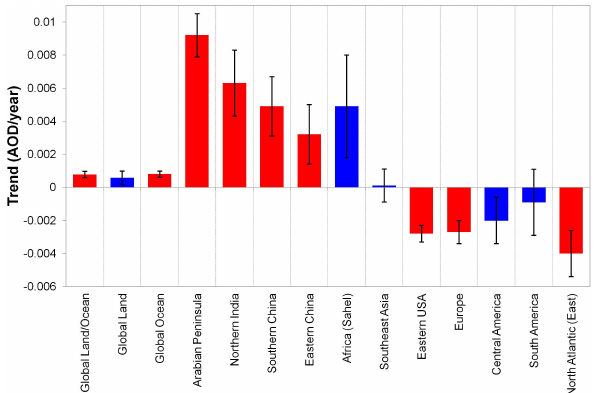
Fig. 9. Comparisons of global and regional annual trends based upon deseasonalised monthly anomaly of SeaWiFS AOD at 550nm from January 1998 to December 2010. Units are AODyr − 1 . Red bars represent regions with AOD trend statistically significant (ex- ceeding 90% confidence), while blue bars indicate regions where statistically significant trend are not found (i.e. with | ω / σ ω | < 1.65). Error bars denote the uncertainty associated with the calculated trend.